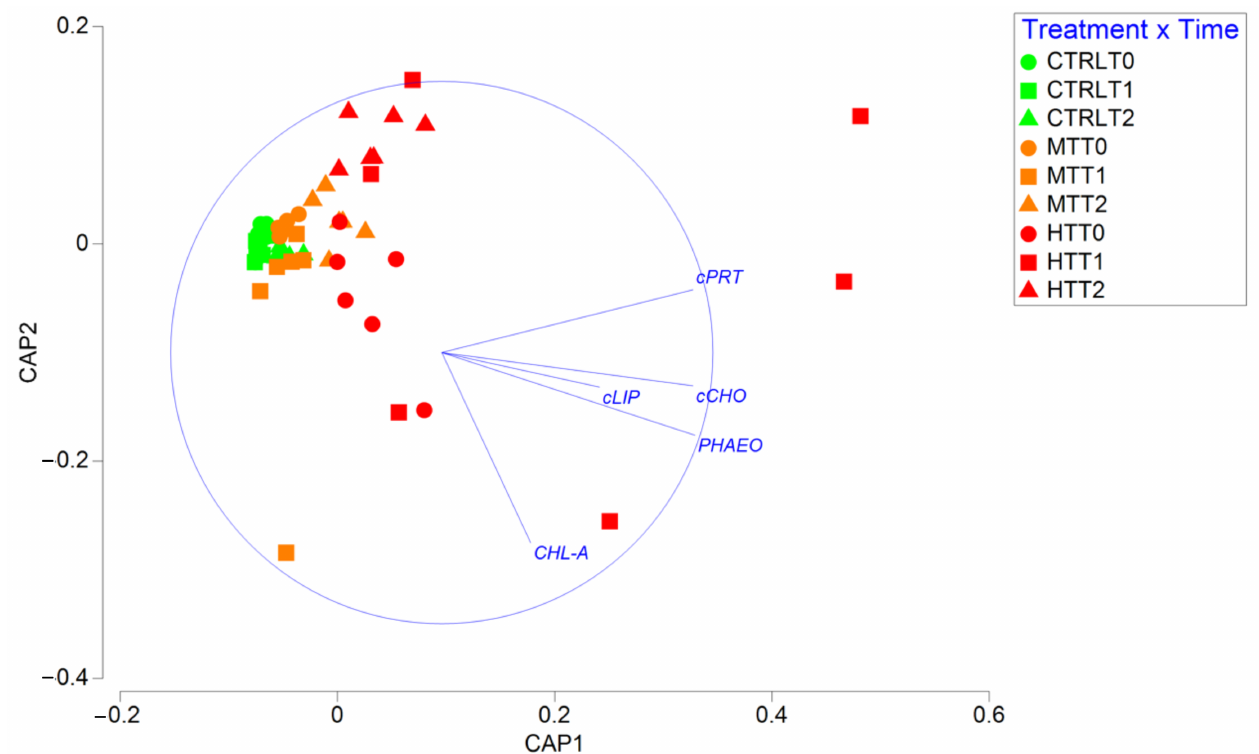
Figure 3. Biplot obtained after CAP analysis showing differences in the biochemical compo- sition of sedimentary organic matter among treatments and sampling times. cPRT = protein; cCHO = carbohydrate; cLIP = lipid; Chl-a = chlorophyll-a; Phaeo = phaeo-pigment. CTRL = control; MT = intermediate temperature anomaly; HT = high temperature anomaly. T 0 = before PPW injection; T 1 = after 3 weeks from PPW injection; T 2 = after 11 weeks from PPW